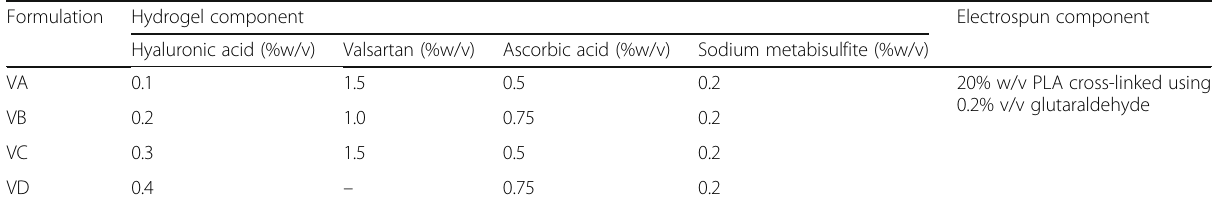
Table 1 Composition of polylactic acid-based electrospun fiber and HA-valsartan hydrogel scaffold